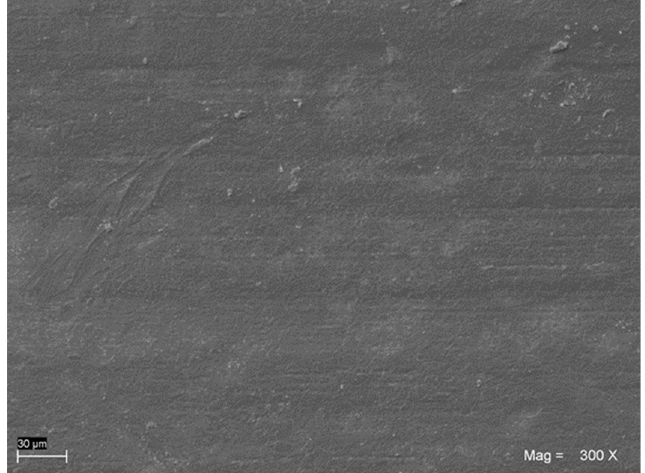
Figure 8. Group 4. The zirconia drill viewed under a scanning electron microscope after 50 disinfection cycles with glutaraldehyde. Sharp margins are free from defects.